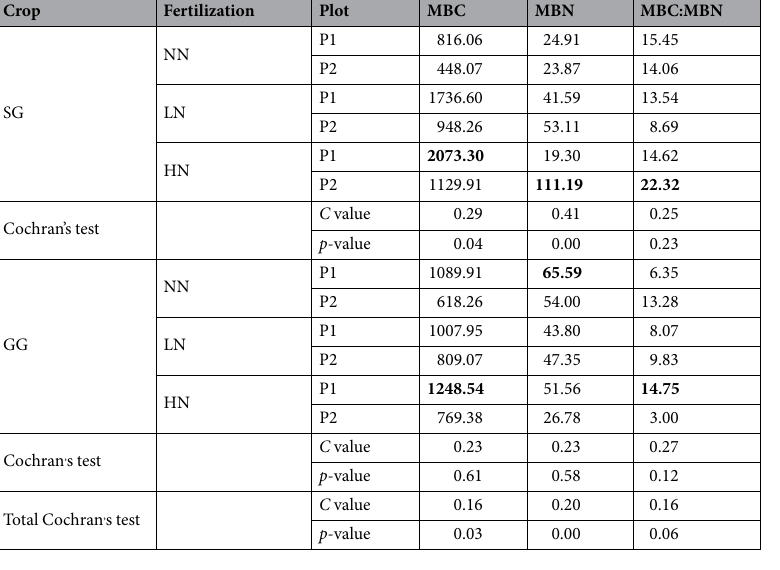
Table 2. Comparison of the variances and Cochran’s C test results for soil MBC and MBN concentrations and MBC:MBN under three N fertilization treatments (i.e. NN, LN and HN) in SG and GG cropland soils in ten or nine plots, respectively at p-value < 0.05 (N = 24). The abbreviations are referred to Table